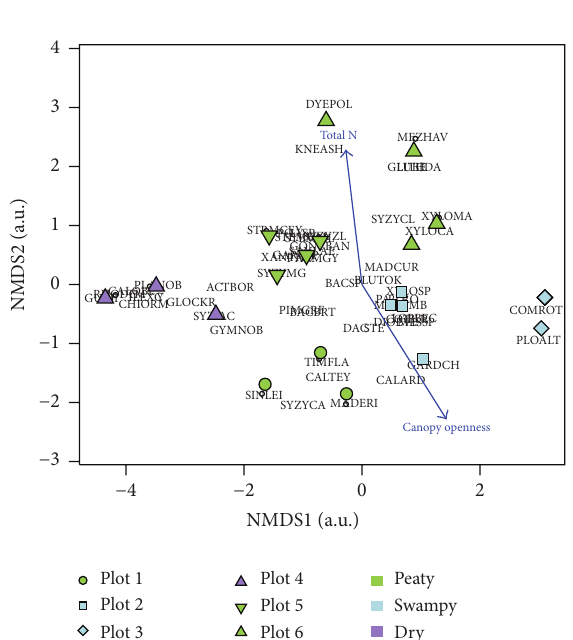
Figure 4: Nonmetric multidimensional scaling (NMDS) of tree species in relation to soil and environmental variables. Different symbols denote the six plots, while the habitat conditions of the plots are denoted by different colours. Species present in the Tutong White Sands plots are denoted by species code in the NMDS ordination space. The species code and full checklist are provided in Supplementary Appendix 1 in Supplementary Material available online at